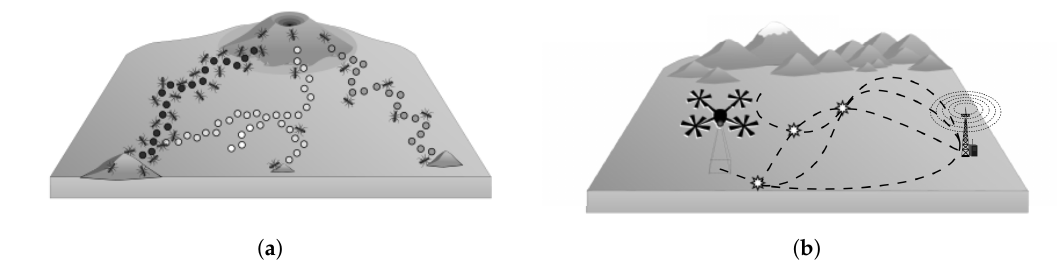
Figure 1. Both the ants and the Unmanned Aerial Vehicles (UAV) forage resources. They must be able to identify dynamic resources with limited energy and temporal constraints. ( a ) Ants foraging; ( b ) UAV performing Data Foraging-Oriented Reconnaissance